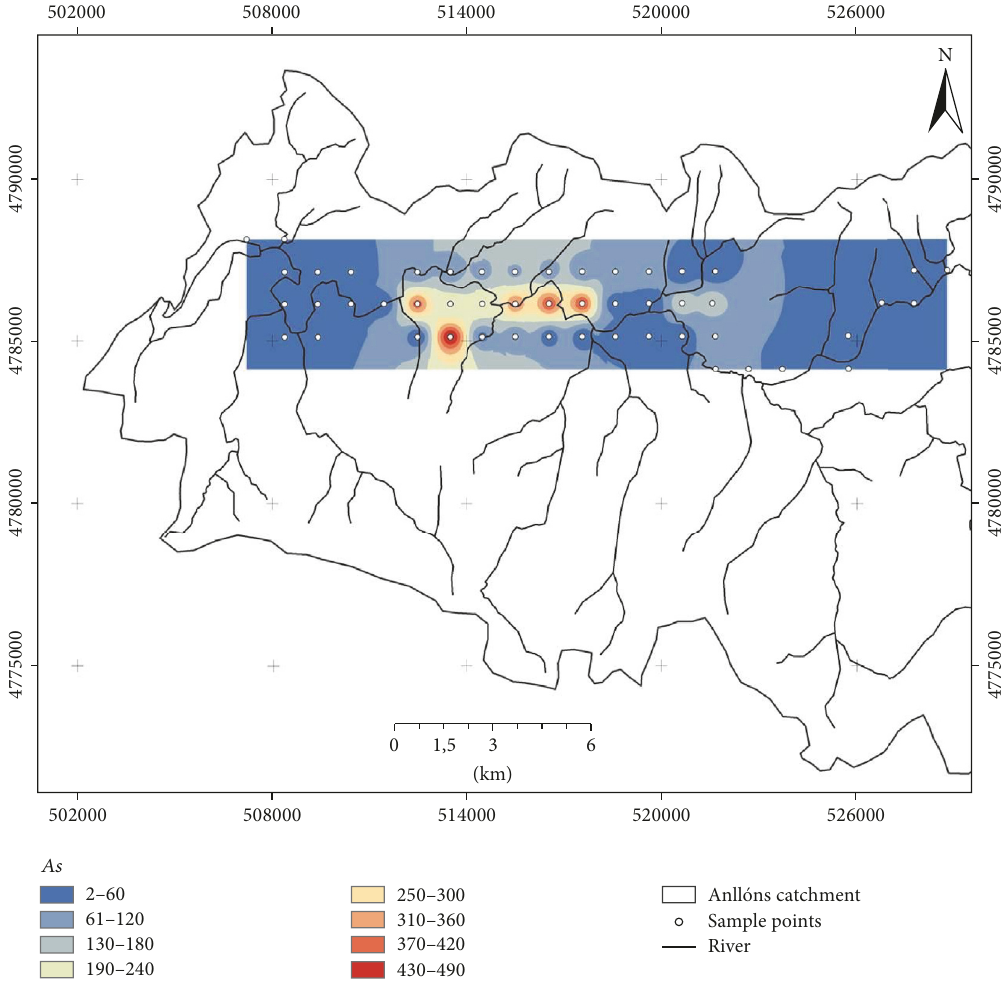
Figure 3: Mapping of pseudo-total